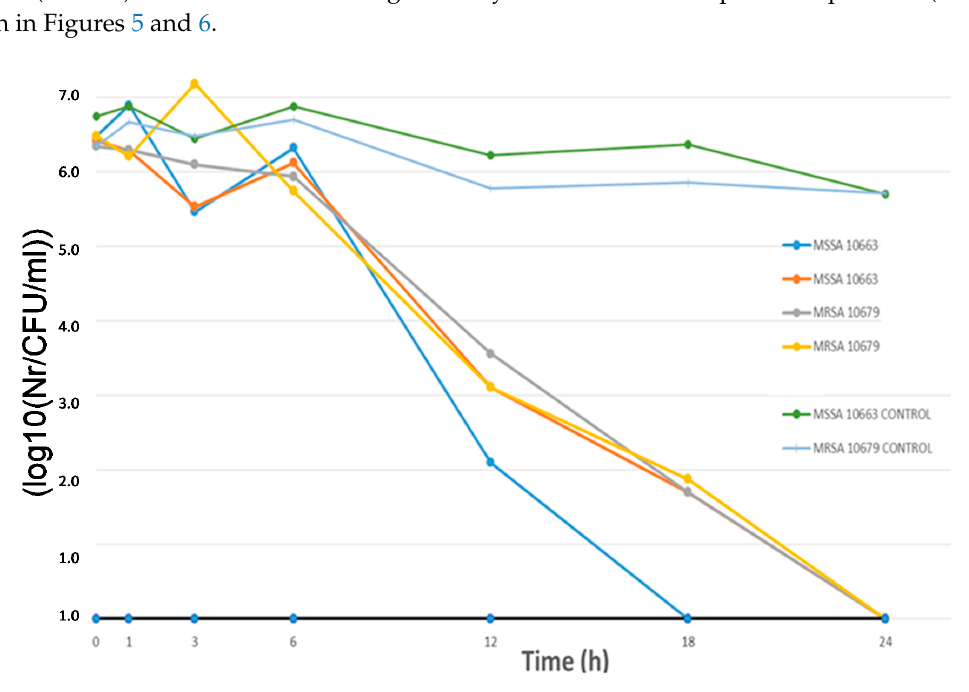
Figure 5. “Time-kill” assay—graphical presentation of antimicrobial efficiency of modified cellulose materials with 100 nm ZnO nanoparticles. The effects were achieved in combination with colloidal platinum (3 nm) against MSSA and MRSA.